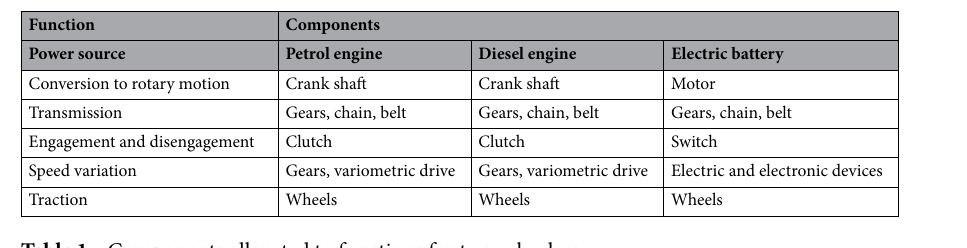
Table 1. Components allocated to functions for